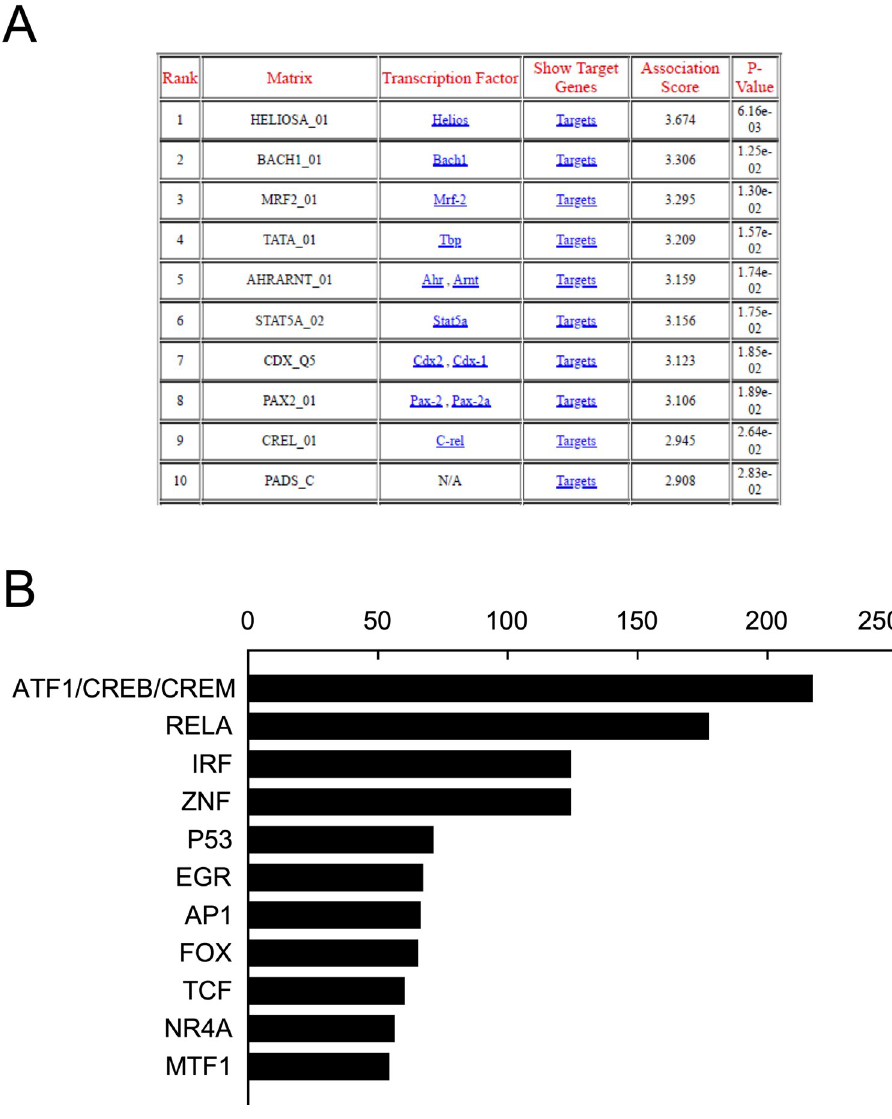
S1 Fig. Forward scatter vs side scatter plot for cytometric